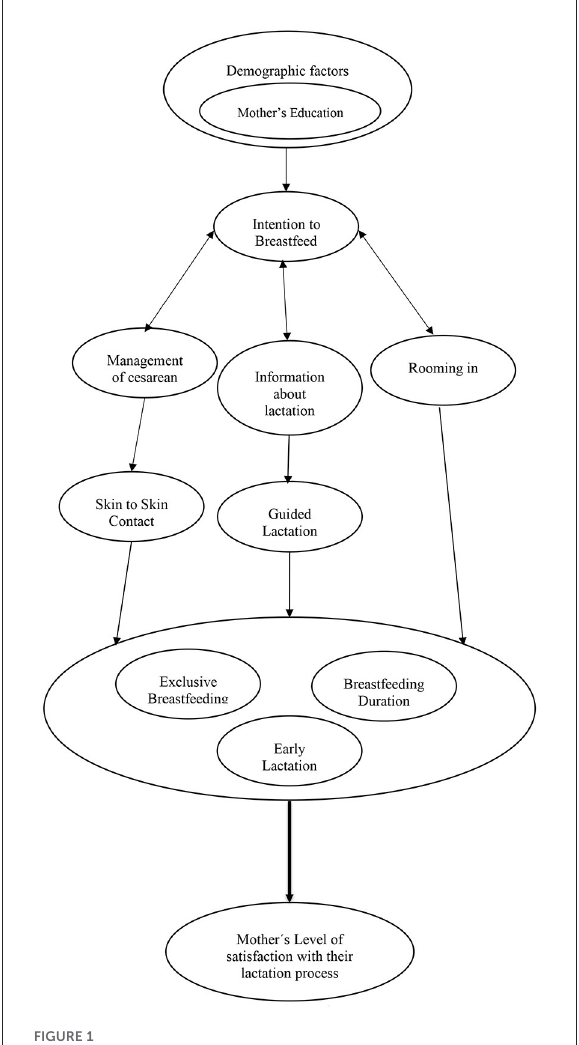
FIGURE1 Clustering map of the grounded theory of successful breastfeeding after pro-lactation cesarean section.